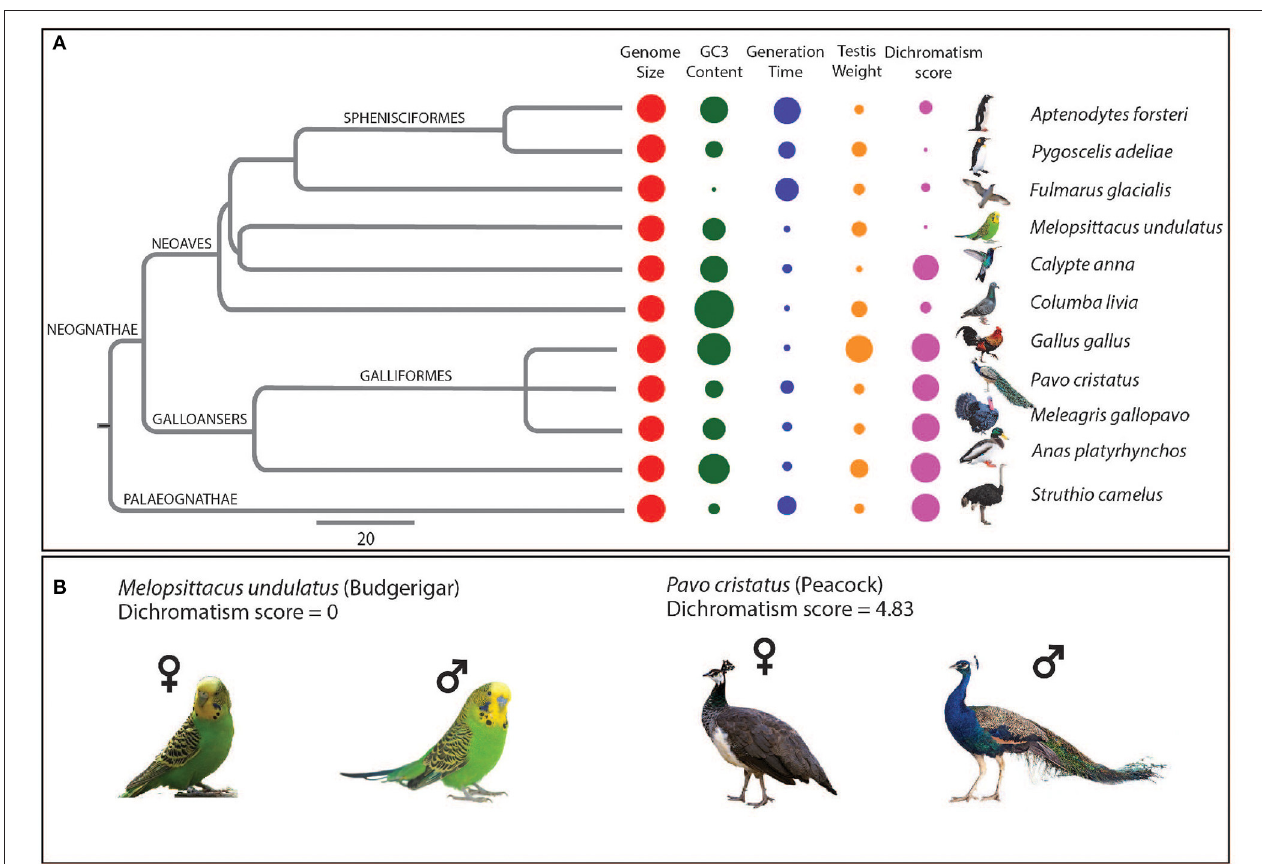
FIGURE 1 | Framework of the analysis to study the genomic signatures of sexual selection in birds. (A) Phylogenetic tree showing the bird species with their corresponding genome size, GC3, Generation time, Relative testis weight, and Dichromatism score depicted as colored circles where the size of the circle indicates the magnitude of the parameter. The species from each of the clades of modern birds phylogenetic tree were represented by hummingbird ( Calypte anna ), emperor penguin ( Aptenodytes forsteri ), northern fulmar ( Fulmaris glacialis ), adélie penguin ( Pygoscelis adeliae ), budgerigar ( Melopsittacus undulates ), and rock dove ( Columba livia ) from clade Neoaves, and peacock ( Pavo cristatus ), chicken ( Gallus gallus ), turkey ( Meleagris gallopavo ), and mallard duck ( Anas platyrhynchos ) from the clade Galloanseres, and common ostrich ( Struthio camelus ) was included from the clade Palaeognathae. (B) Images of males and females for peacock ( Pavo cristatus ) and budgerigar ( Melopsittacus undulatus ) along with their mean dichromatism score obtained from a survey of seven trained ornithologists ( Supplementary Table 2